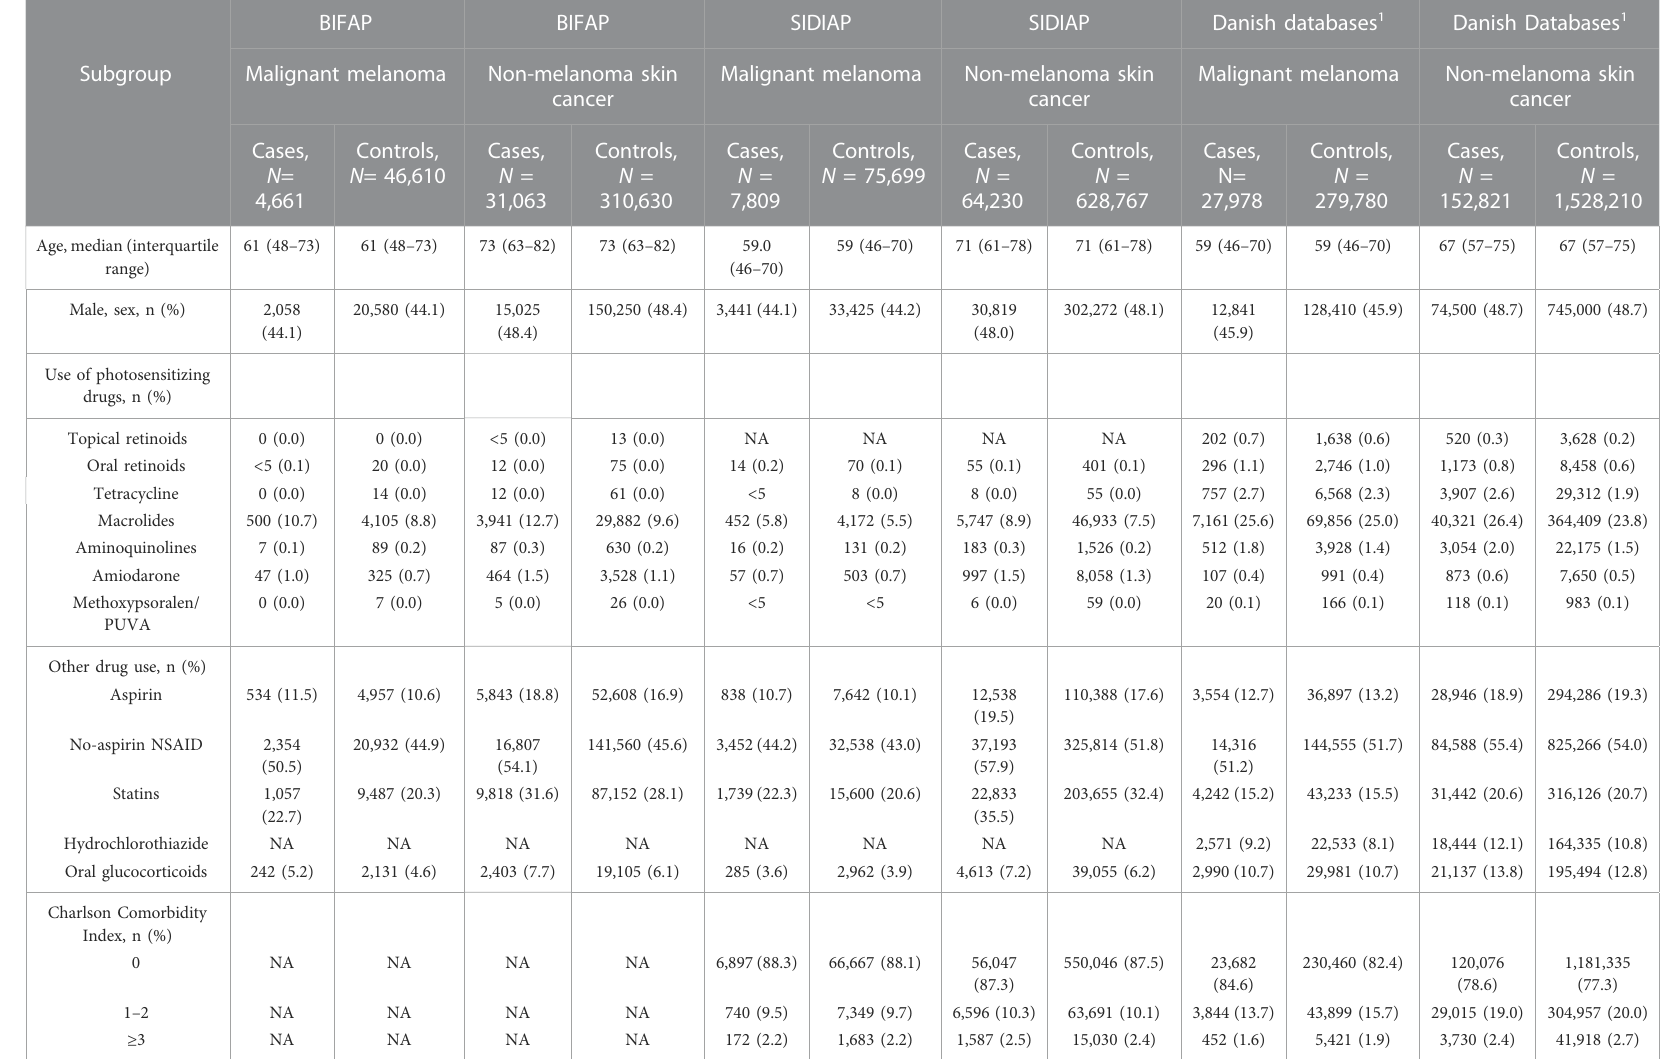
TABLE 1 Characteristics of melanoma and non-melanoma skin cancer cases and matched controls in BIFAP, SIDIAP, and Danish